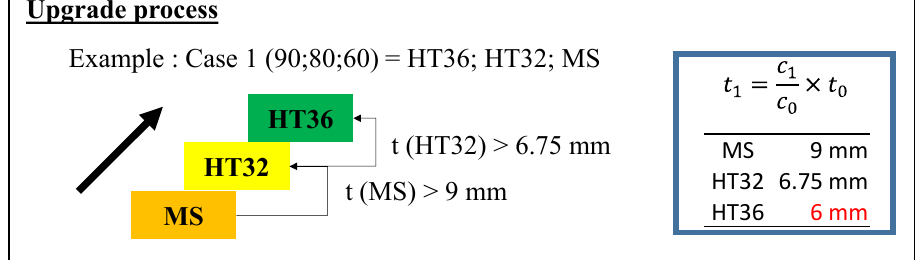
Figure 5. Upgrading process.